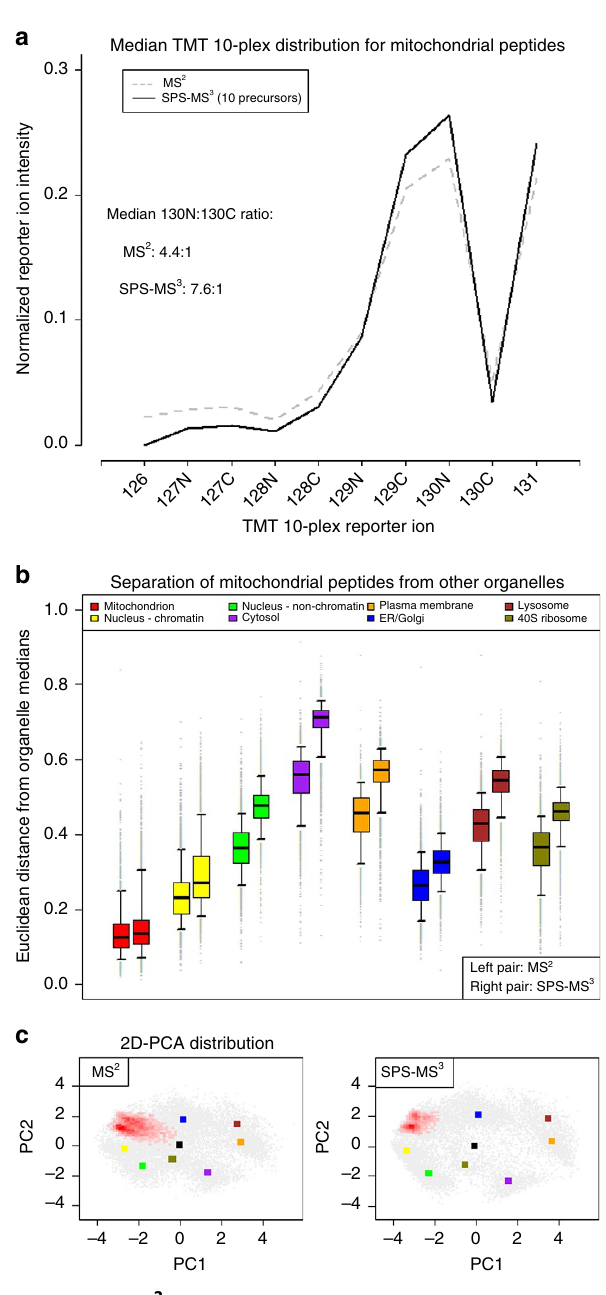
Figure 2 | SPS-MS 3 enhances resolution of the mitochondrion from other organelles. ( a ) SPS-MS 3 results in higher quantitative accuracy. The ratio between TMTchannels expected to be enriched in mitochondria (129C and 130N) and channels that are expected to be depleted (for example, 130C) is markedly increased by SPS-MS 3 . ( b ) The distance of mitochondrial PSMs from the median of eight organellar phenotypes. The distance of mitochondrial PSMs from the median mitochondrial distribution does not change significantly between MS 2 and SPS-MS 3 , but the distances from other organelles are all significantly increased in SPS-MS 3 (Wilcoxon rank sum test P value o 2.2 (cid:2) 10 (cid:3) 16 ), indicating greater organellar resolution. ( c ) When represented in two dimensions by PCA, the mitochondrial PSMs (red heat map) show less skew towards the origin, due to the improved specificity of SPS-MS 3 quantification. The median positions of other organelles are represented by coloured squares and individual proteins by grey points. Similar plots demonstrating the enhanced resolution of other organelles are presented in Supplementary Fig.